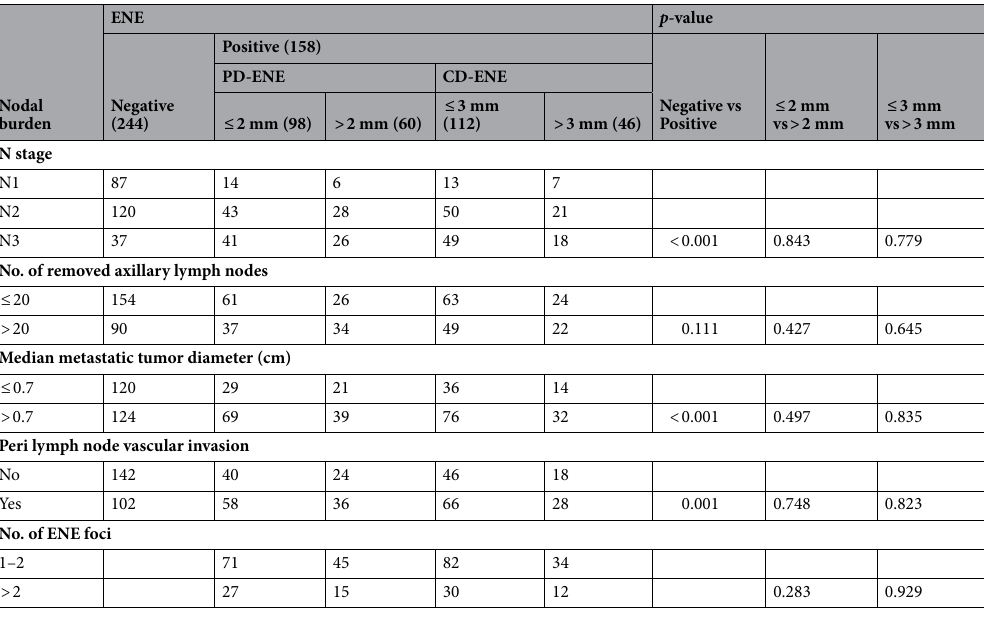
Table 3. ENE in ALN and nodal burden. ENE extranodal extension; PD-ENE perpendicular diameter of extra-nodal extension; CD-ENE, circumferential diameter of extra-nodal